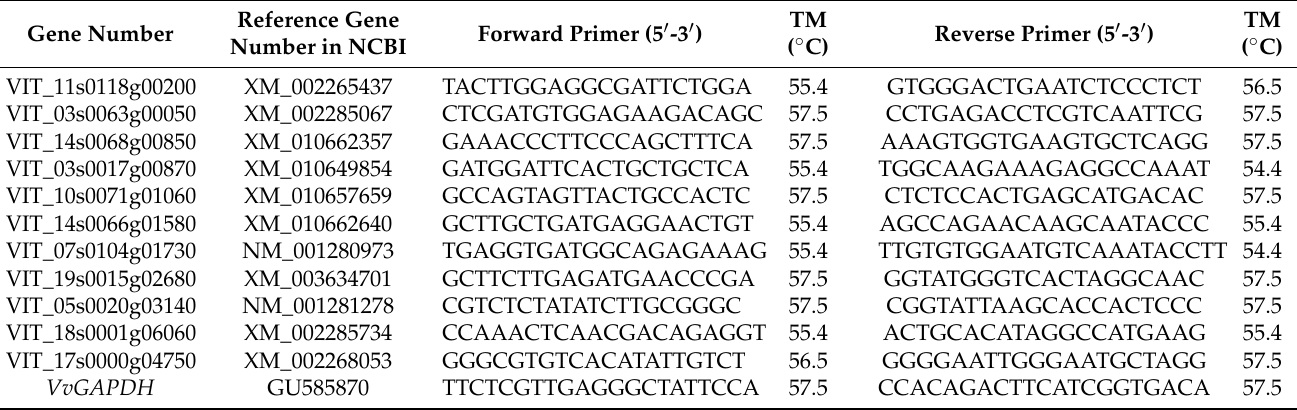
Table 1. Gene primers for